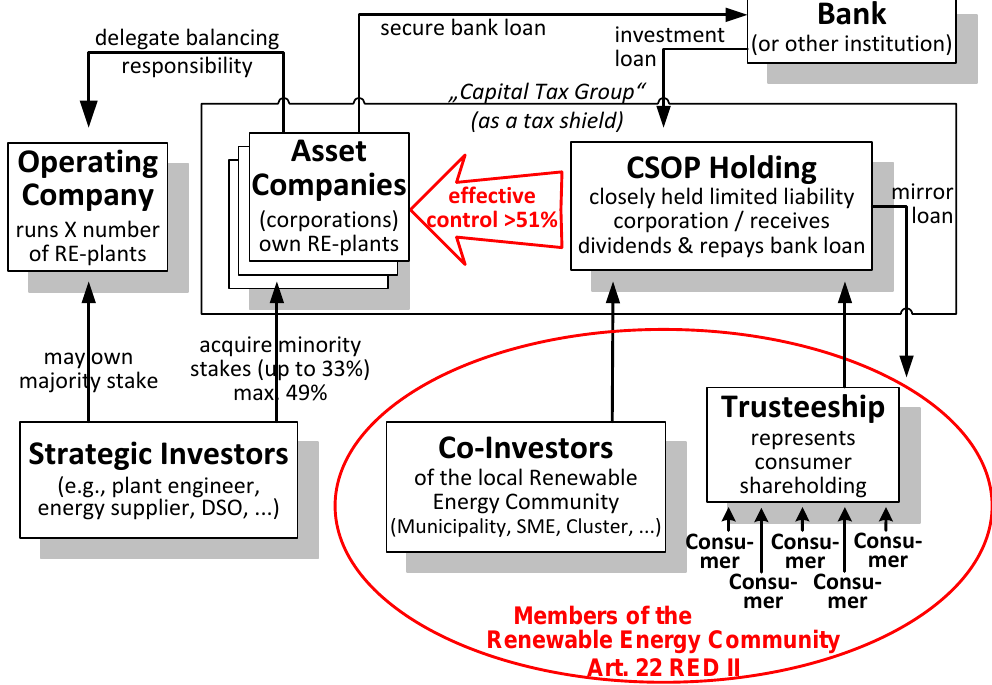
Figure 5. Key elements of pooled / upscaled RE-CSOP investments with strategic investors for a REC at Level III. (Source: Own elaboration).